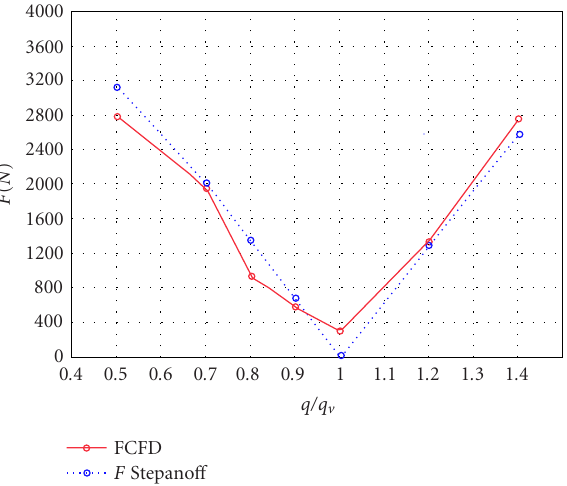
Figure 24: Radial thrust versus flow rate ratio, NS32 pump, α = 0 ◦